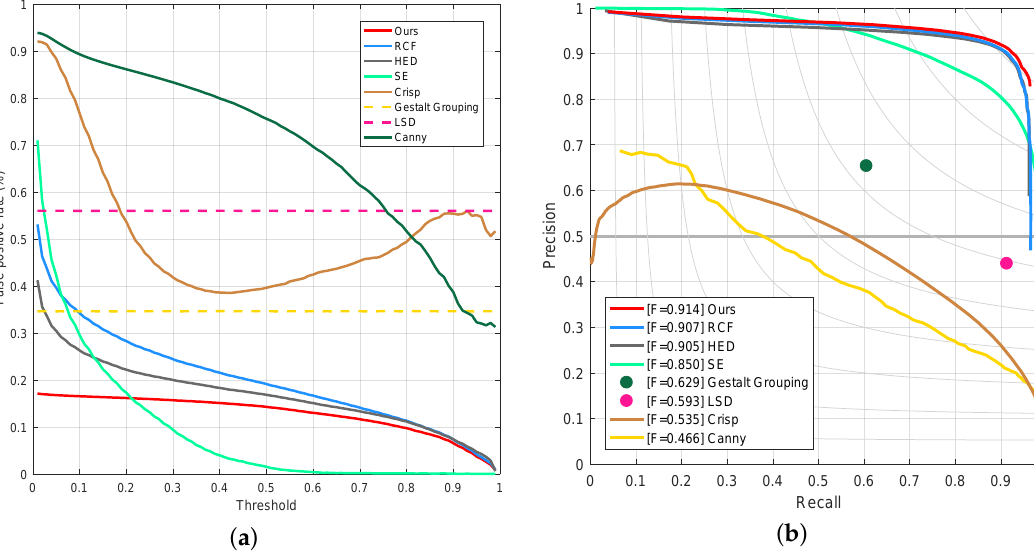
Figure 7. The evaluation results on PLDU dataset. Our proposed method achieves the lowest false positive rate and superior F 1 -measure (ODS = 0.914) compared with baselines. ( a ) The false positive rate curves at different thresholds on PLDU dataset; ( b ) The precision-recall curves on PLDU